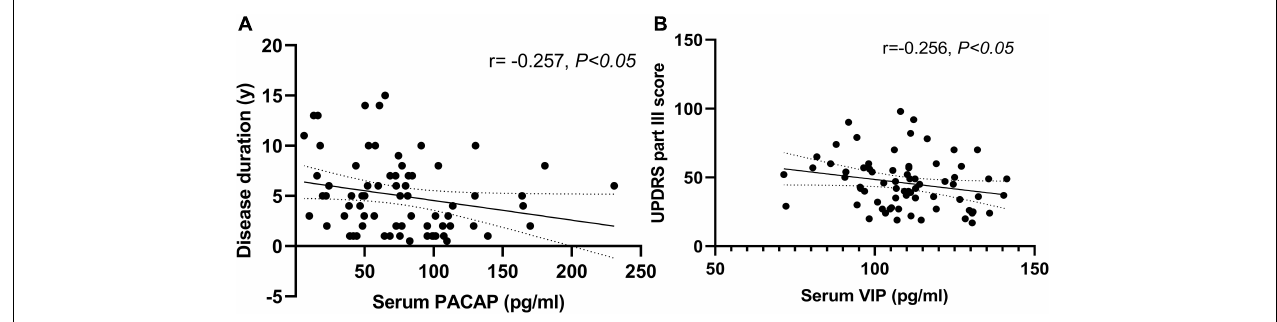
FIGURE 4 | Correlation of serum pituitary adenylate-cyclase activating polypeptide (PACAP) and vasoactive intestinal peptide (VIP) levels with disease duration and disease severity in PD patients. (A) Serum PACAP levels were negatively correlated with disease duration (Spearman’s correlation coefficient r = –0.257, P < 0.05, and n = 72). (B) Serum VIP levels were negatively correlated with UPDRS part III scores (Pearson’s correlation coefficient r = –0.256, P < 0.05, and n =